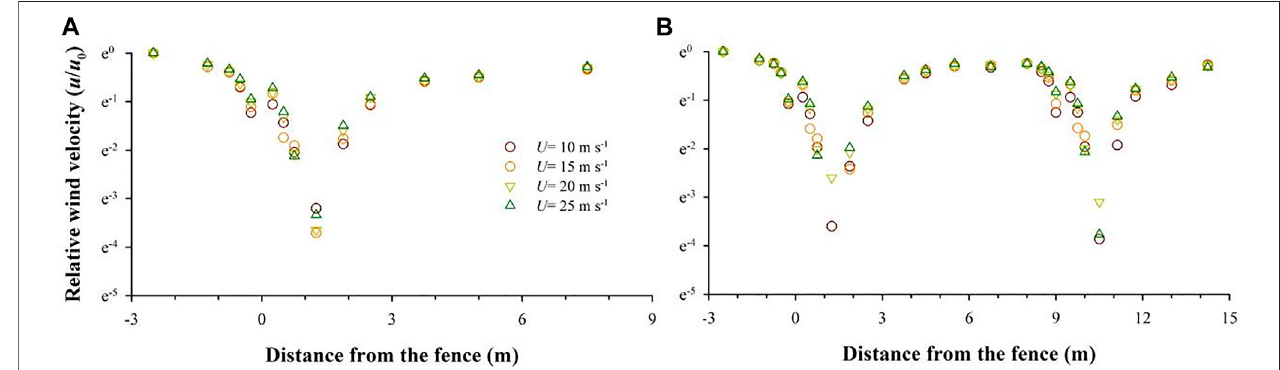
FIGURE 7 | Relative wind velocity versus distance for the (A) single-row straight-installed plate (SIP) and (B) double-row SIPs at a height of 13 cm (0.52 H ) under different free-stream wind velocities.